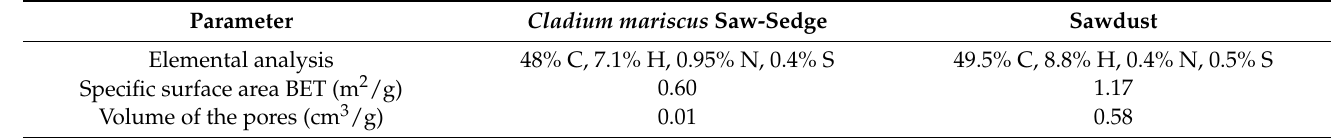
Table 1. Low-cost sorbents